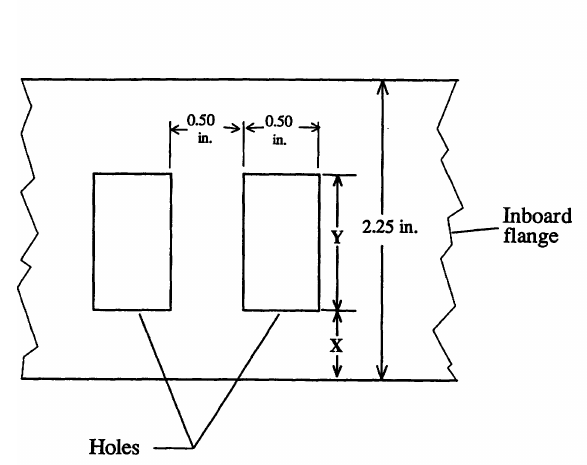
FIGURE 19 Two parameters for hole pattern design study.